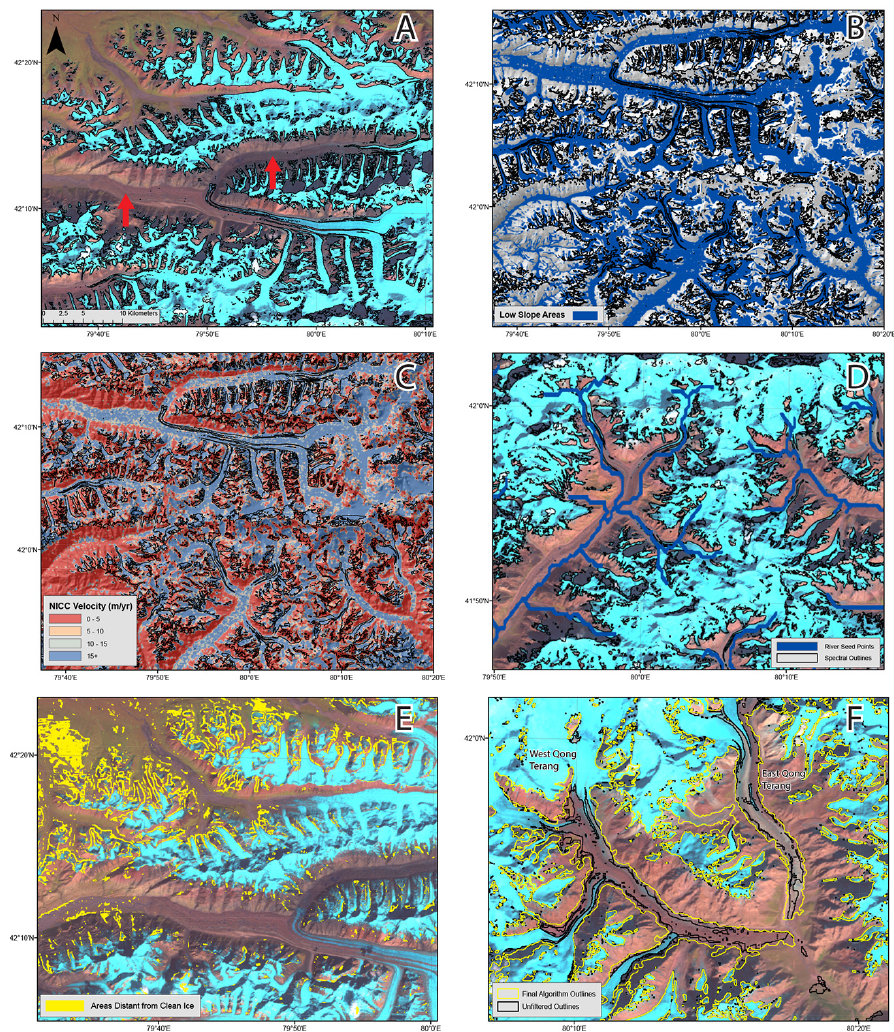
Figure 2. (a) Characteristic example of a debris-covered glacier tongue (Inylchek Glacier). Spectrally delineated glacier outlines (black), over Landsat bands B7/B5/B3 (R/G/B), from image LC81470312013268LGN00, with poorly mapped debris-covered tongues (red arrows). (b) Blue areas show “potential debris areas”, as delineated by slopes between 1–24 ◦ , with elevations below ∼ 2500m removed, SRTM hillshade underneath, clean-ice outlines overlain in black. (c) Example of a glacier velocity surface, generated using normalized image cross- correlation (NICC). Areas in red are slow-moving areas and represent stable ground, clean-ice outlines overlain in black. (d) Example of distance-weighting seed areas used to remove pixels from the “potential debris areas” which are distant from either a river valley or classified glacier ice. Rivers in blue, clean-ice outlines overlain in black. (e) Areas removed by second distance-weighting step (yellow). (f) Impacts of statistical filtering on glacier outlines, with areas in black removed during the filtering process. East and west Qong Terang